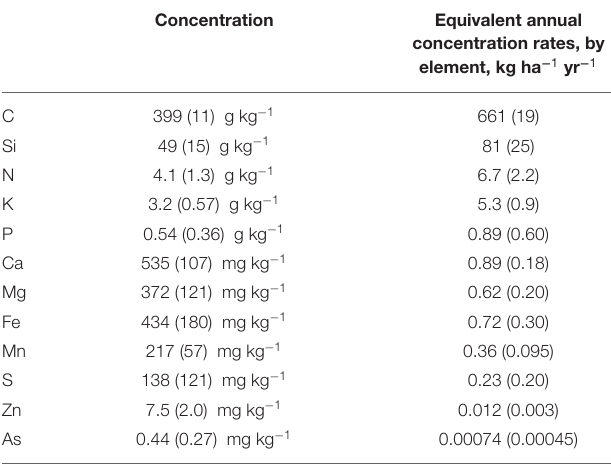
TABLE 1 | Average elemental concentrations of rice husks harvested in Arkansas from several different farms in 2012, 2013, 2018, and 2019, determined by digestion and inductively coupled plasma